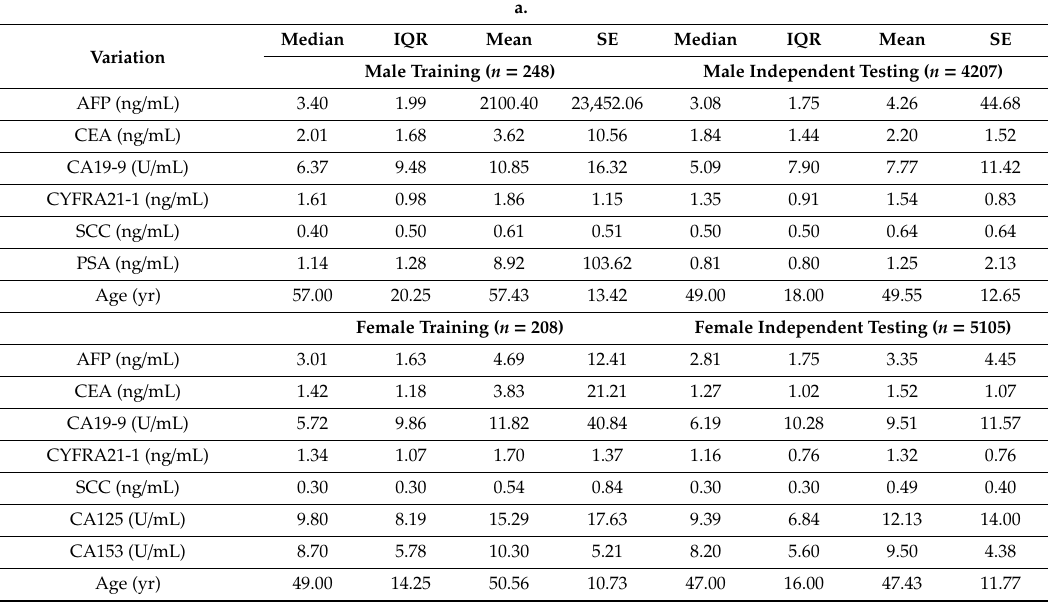
Table 1. a. Descriptive statistics of training and independent testing datasets. b. Cancer types in male training and independent testing datasets. c. Cancer types in female training and independent testing